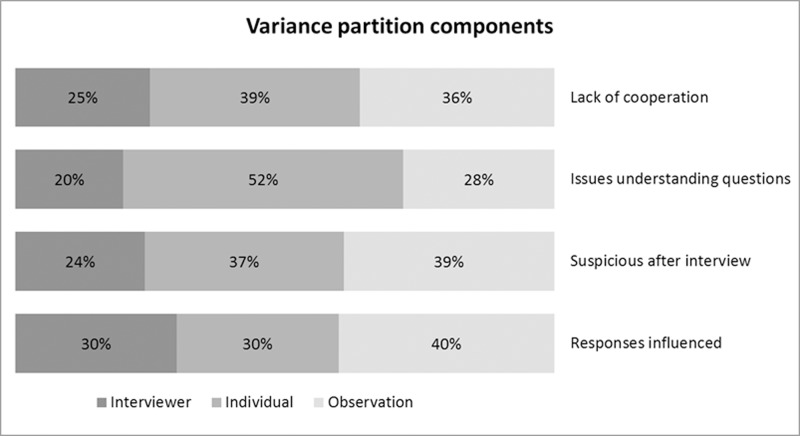
Variance partition components.HILDA Survey data (2001–2012). Multiple-membership three-level logistic regression models with no predictors. n (int) = 542; n (ind) = 20,708; n (obs) = 128,903.